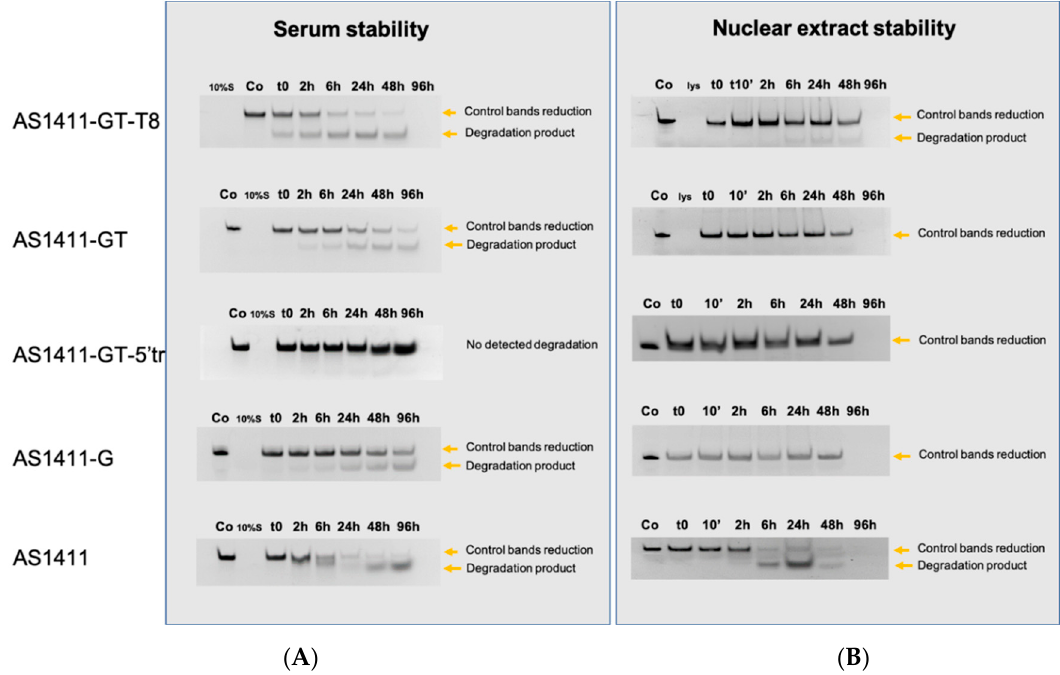
Figure 4. Stability of GROs in serum-containing medium and in nuclear extract. GROs were incubated with ( A ) 10% FBS or ( B ) 100 µg of nuclear extract at different times (0–96 h). Samples were analyzed by 16% polyacrylamide gel electrophoresis. Co = oligonucleotide alone, S = fetal bovine serum, lys = nuclear lysate.